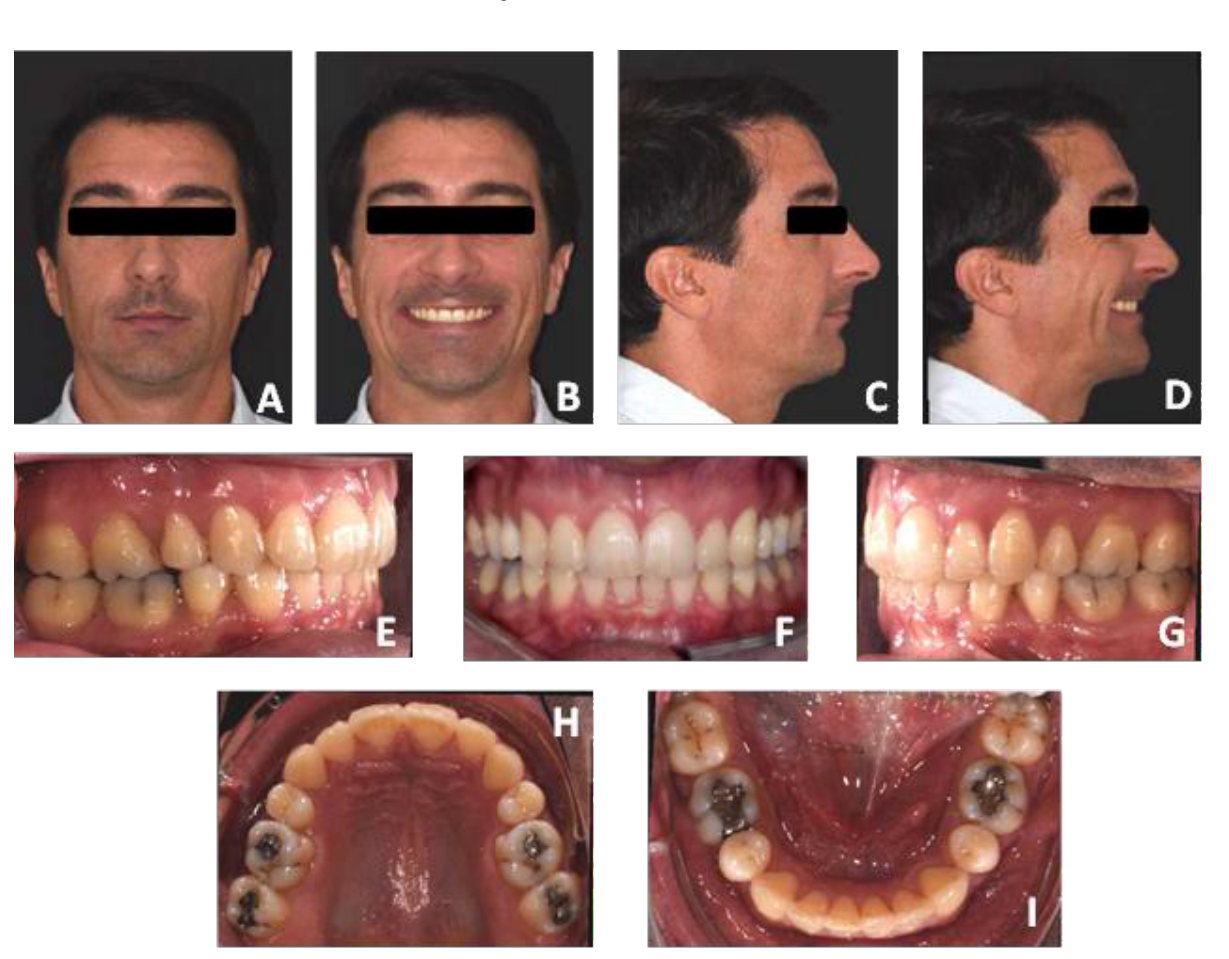
Figure 12. Post-treatment extraoral and intraoral photos of case number 1: frontal facial view ( A ); frontal facial view smiling ( B ); right facial view ( C ); right facial view smiling ( D ); right arches view ( E ); frontal arches view ( F ); left arches view ( G ); upper arch occlusal view ( H ); lower arch occlusal view ( I ).